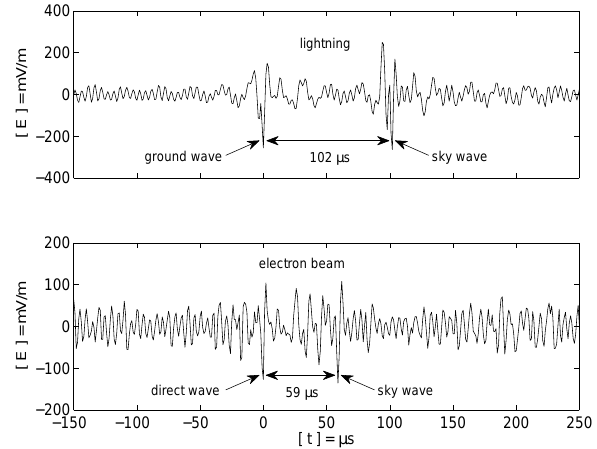
Fig. 5. The burst of electromagnetic radiation from the lightning discharge is composed of two consecutive pulses which are delayed by ∼ 102µs (upper panel). The first pulse results from the elec- tromagnetic wave which propagates along the surface of the Earth to the receiver (ground wave). The second pulse results from the electromagnetic wave which is reflected from the ionosphere (sky wave). The burst of electromagnetic radiation from the electron beam is also composed of two consecutive pulses (lower panel). The short time delay of ∼ 59µs indicates that the electron beam is located above the thundercloud where it emits an electromagnetic wave which propagates at an angle to the receiver (direct wave).